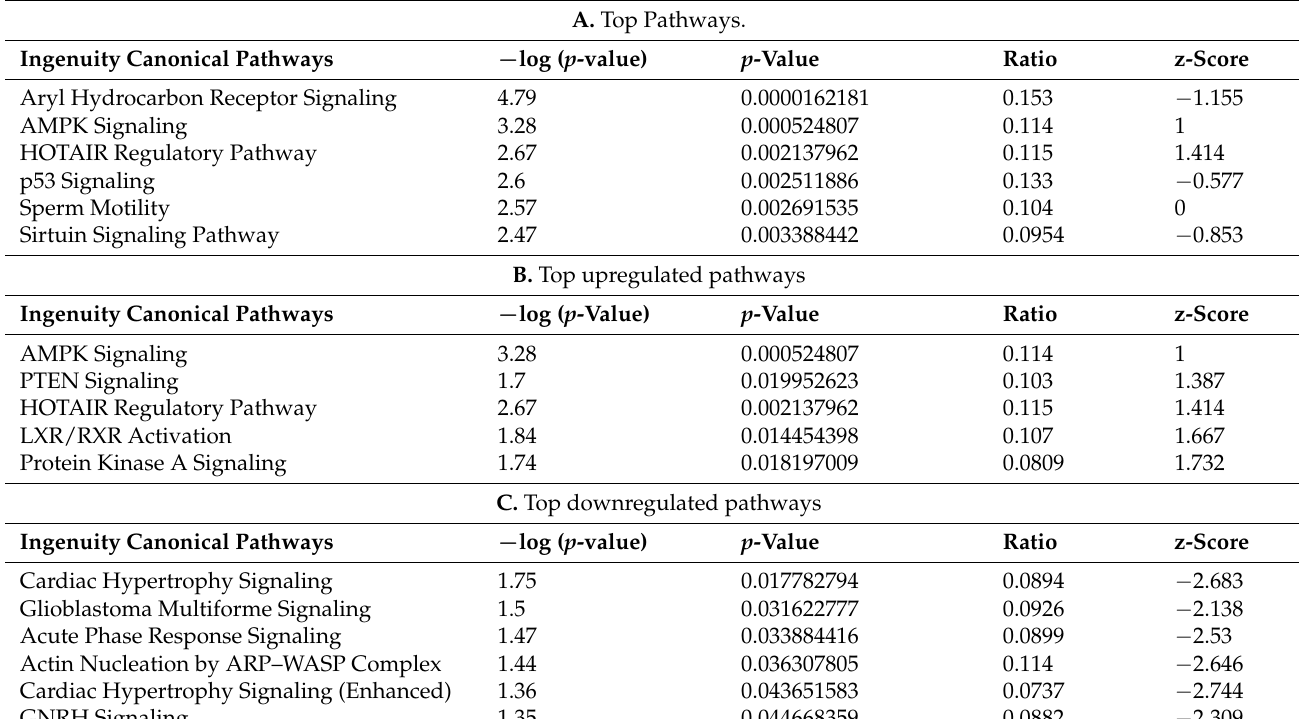
Table 2. Top canonical pathways. A. Top Pathways.